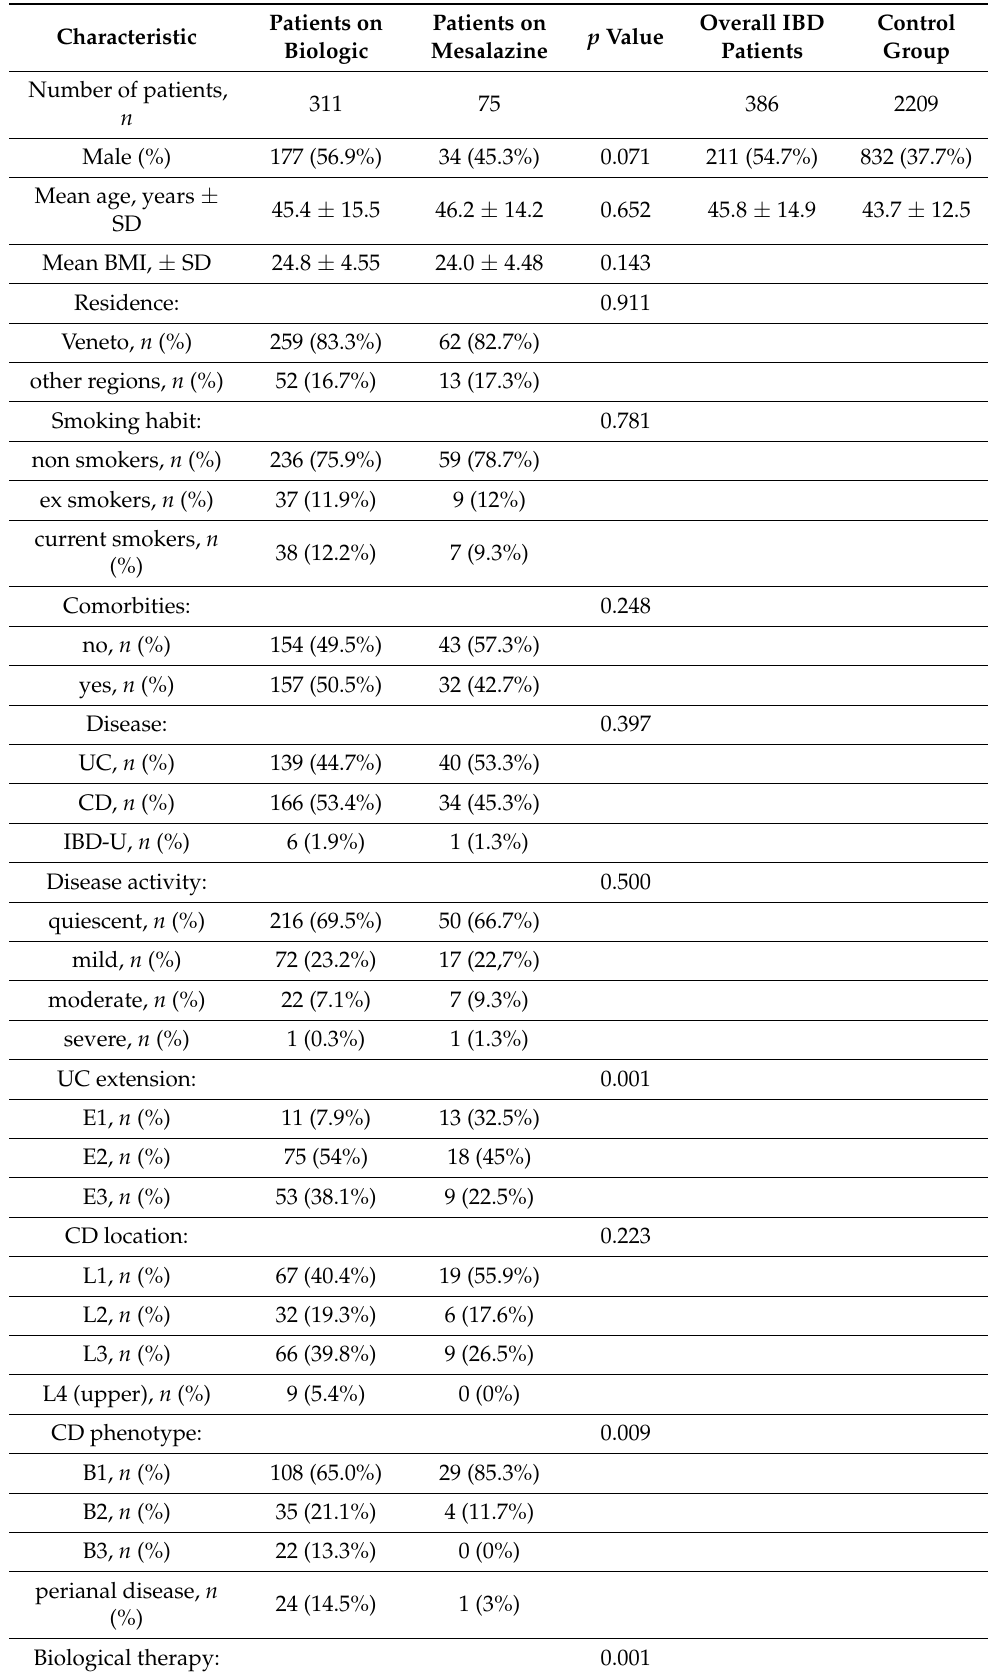
Table 1. Demographic and clinical characteristics of patients